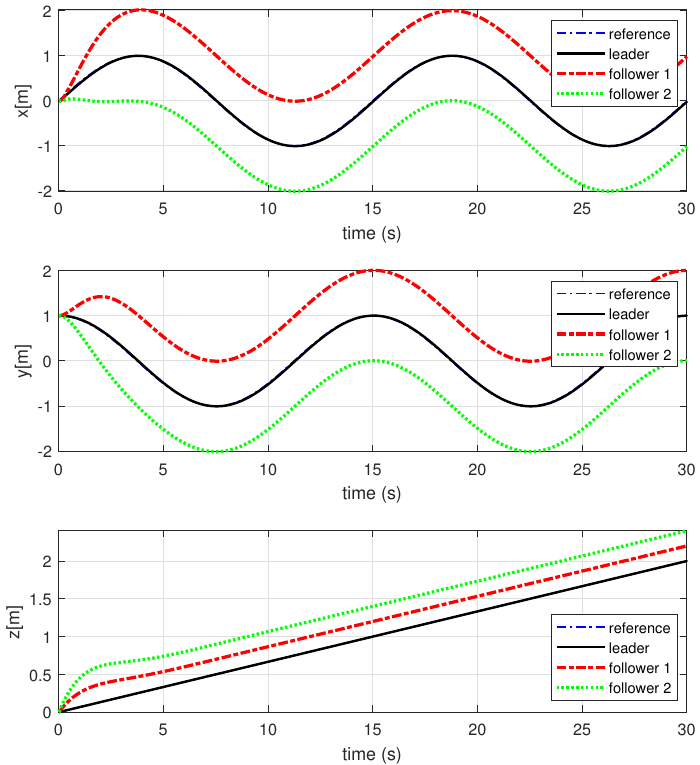
Figure 5. The simulation result for the formation control of quadrotors in each of the three axis: The solid line indicates the trajectory of leader quadrotor, and the dashed lines are the trajectories of each follower